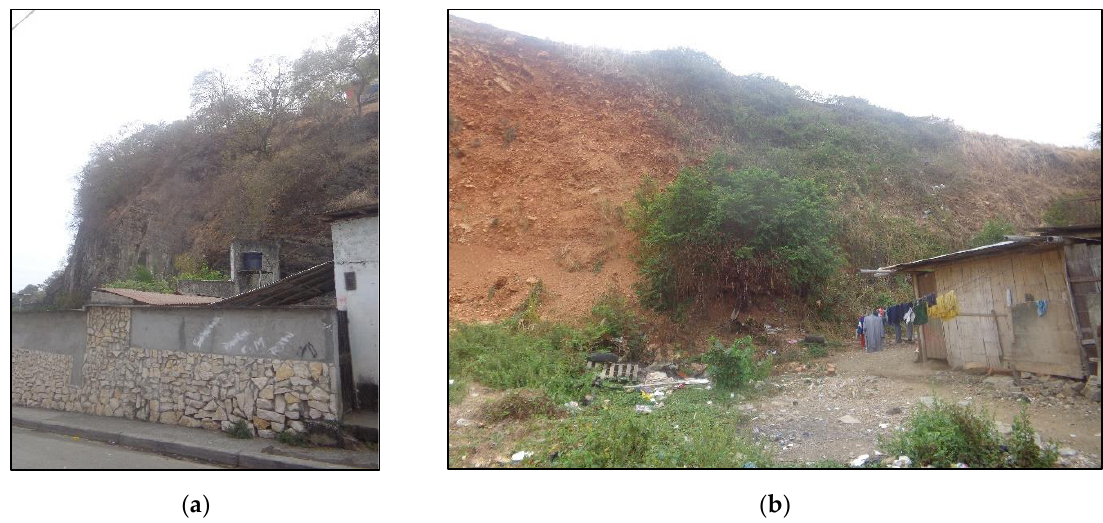
Figure 4. ( a ) Sandstone rock mass with intercalations. ( b ) Lateritic soil product of residual shale weathering. Eight rock samples were taken using the combo and chisel or easily removable